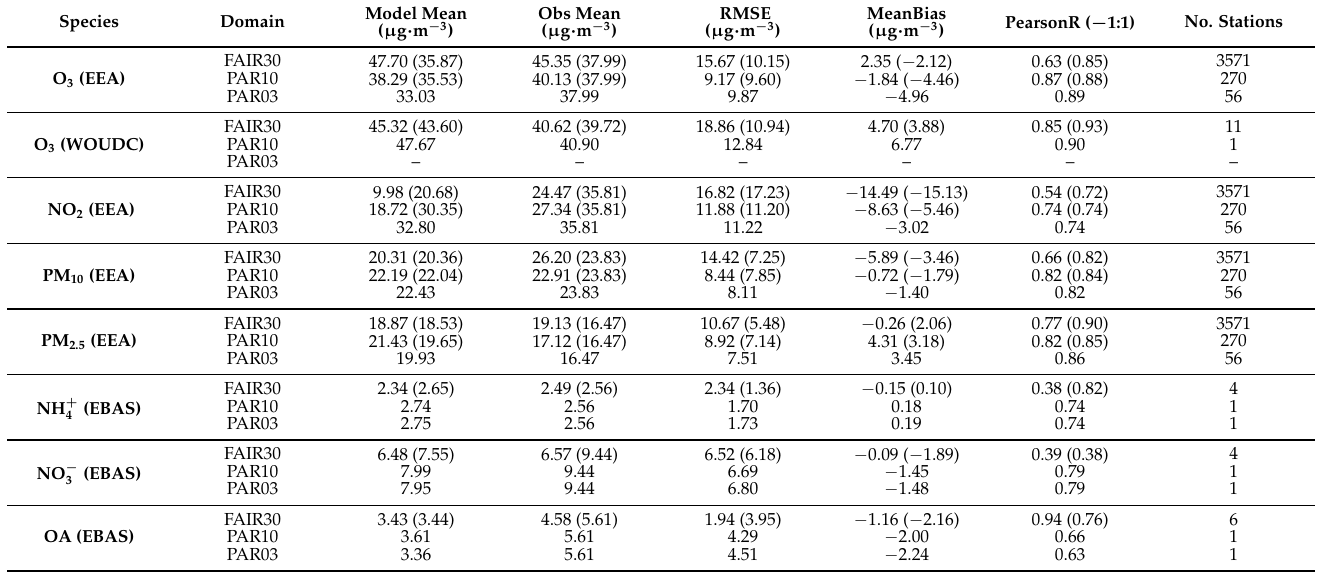
Table 3. Error statistic for chemical species shown in Figure 3. Units are given on the left side of each section. Comparisons are separated by type of station; types of stations are also given on the left side of each section. All the stations are shown in (Figure 2). The values given in the brackets for FAIR30 and PAR10 show the error statistics for common stations between all